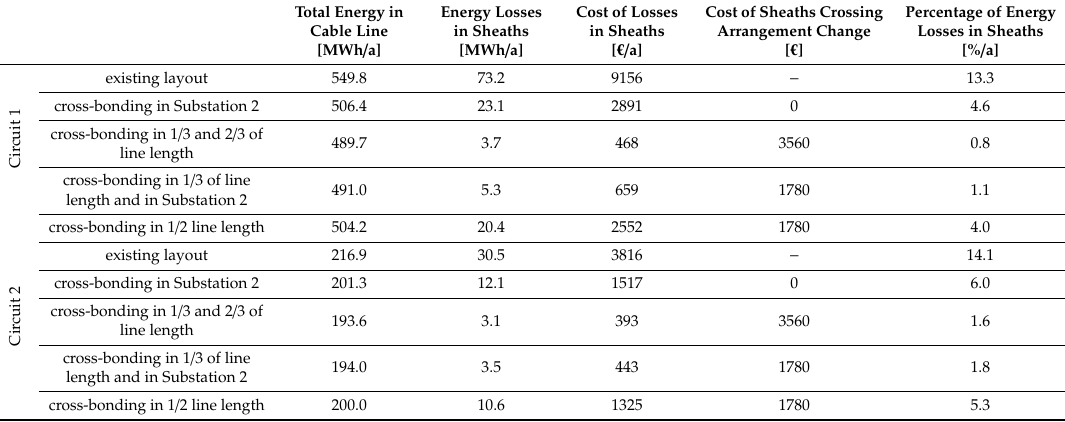
Table 2. Annual energy losses for di ff erent variants of cables sheaths crossings